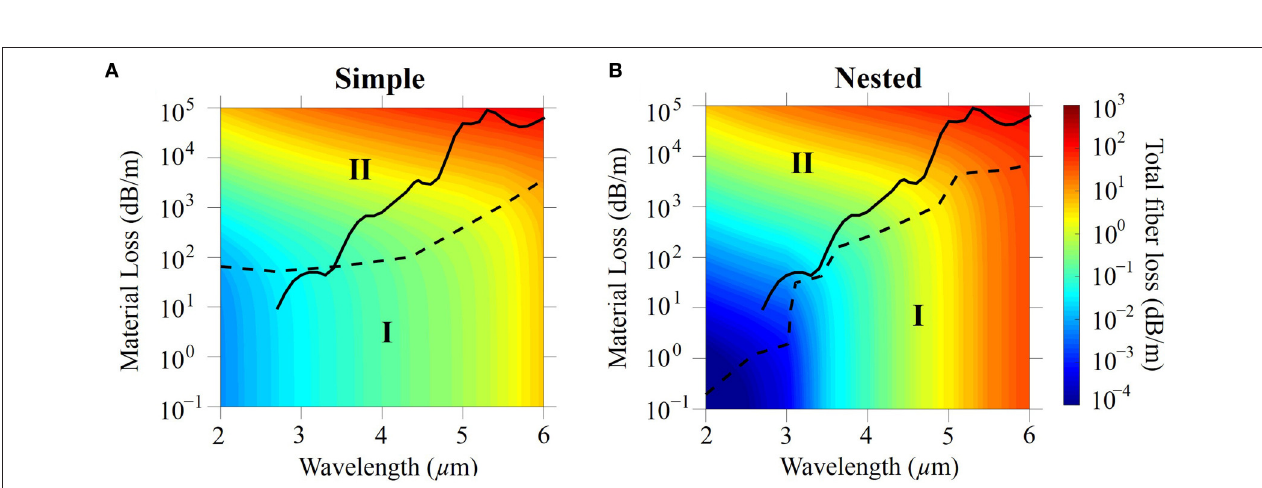
FIGURE 6 | Contour plot of fiber loss in (A) simple and (B) nested negative curvature fibers made with silica glass. The black solid curves show the material loss of silica glass. The black dashed curves separate regions I and II.